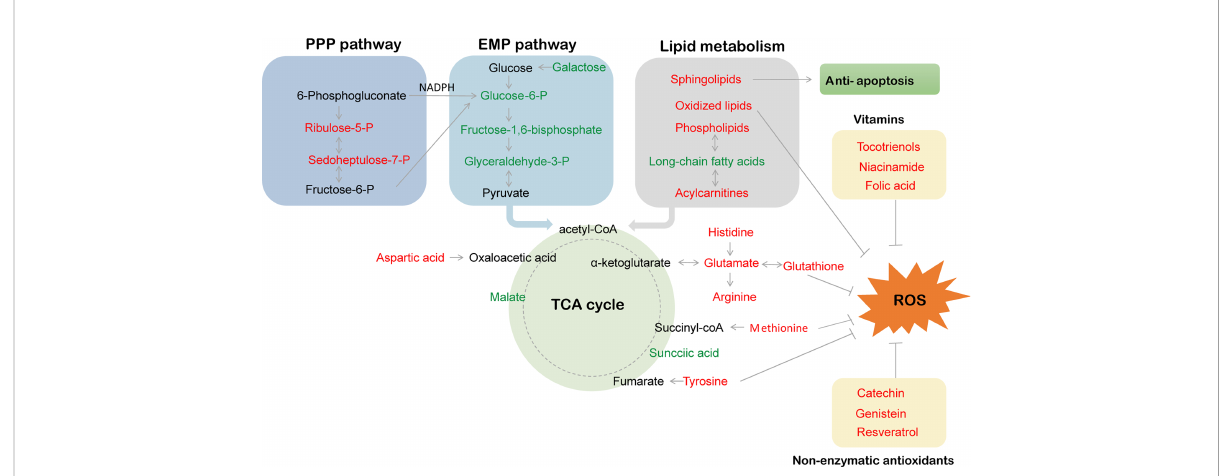
FIGURE 4 The hypothetical metabolic response map during estivation cycles. PPP pathway, EMP pathway and ROS respectively represent pentose- phosphate pathway, embden meyerhof pathway and reactive oxide